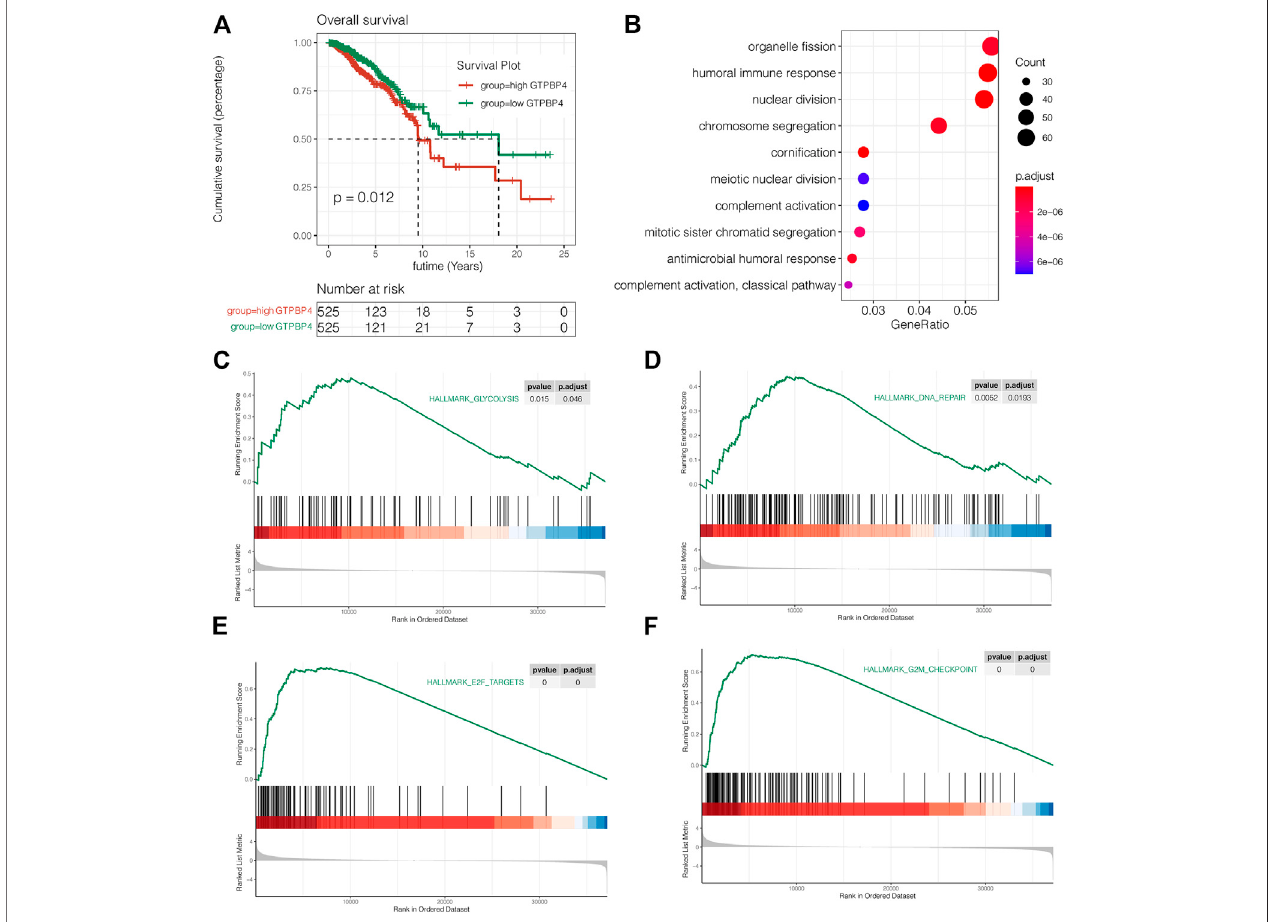
Depicted the Flow Chart of Our Work Expression Analysis of GTPBinding Protein4 in TIMER and UALCAN